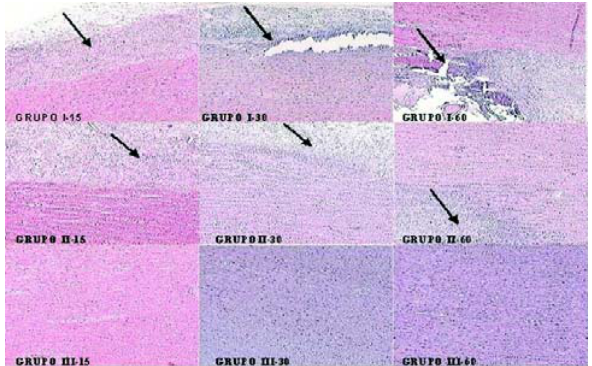
Fig. 1- Fotomicrografia de condutos aórticos dos três grupos estudados, nos três períodos observados (hematoxilina & eosina 100X). No grupo I, com o passar do tempo há um avanço do infiltrado inflamatório para o centro do implante, levando ao rompimento das fibras da matriz. No grupo II, não se observa invasão do infiltrado para o interior do implante. No grupo III, não há evidência de células mononucleares